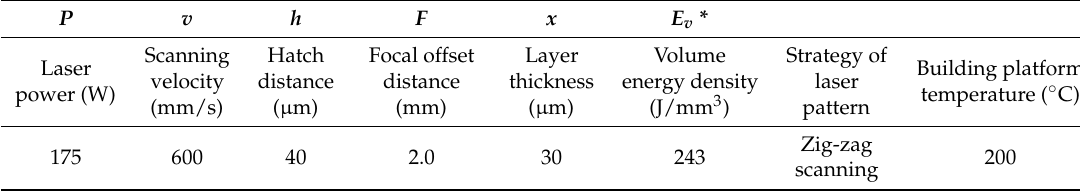
Table 1. Main processing parameters used for the selective laser melting (SLM)